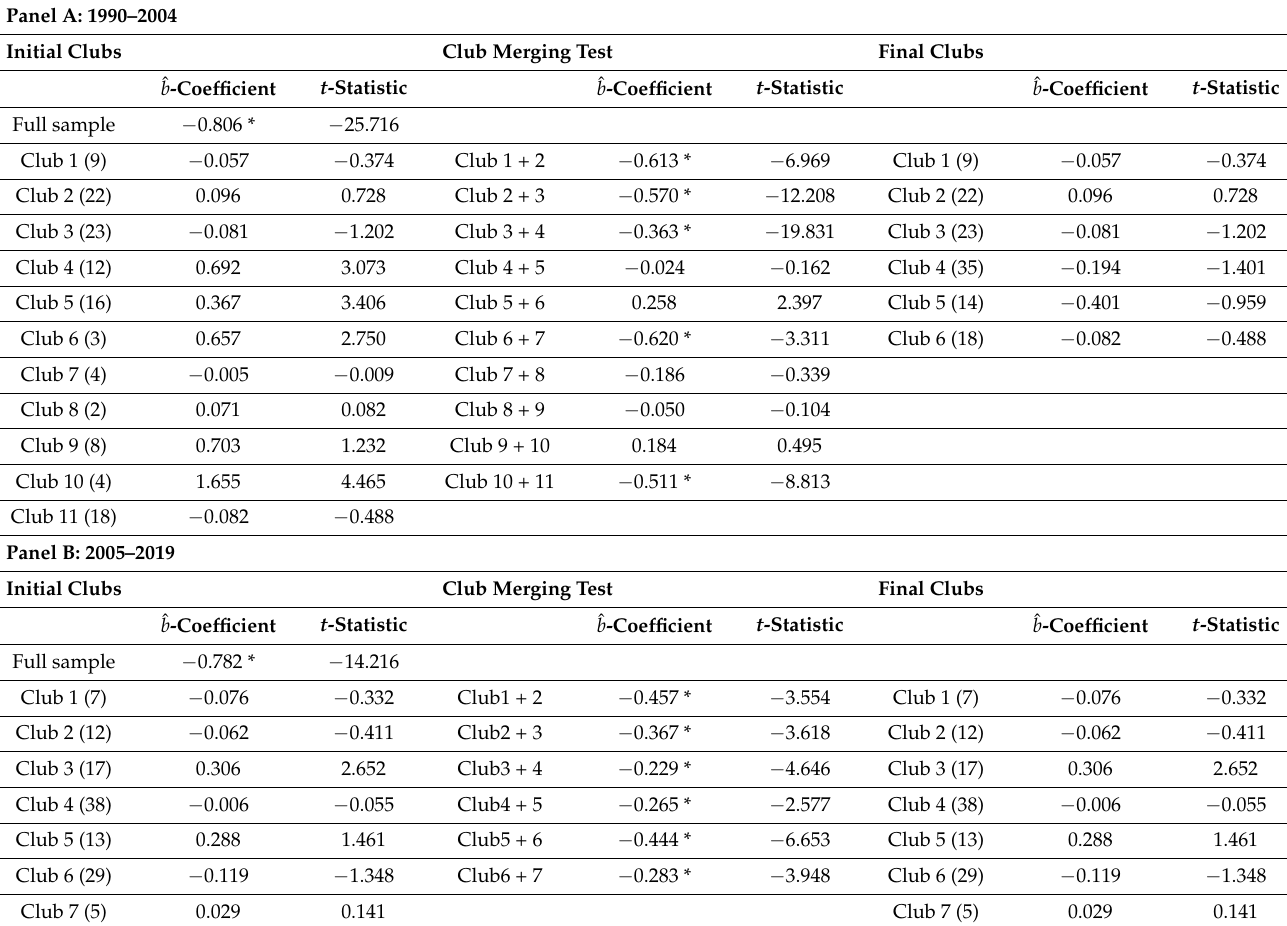
Table 3. Club convergence results before and after the Kyoto Protocol came into